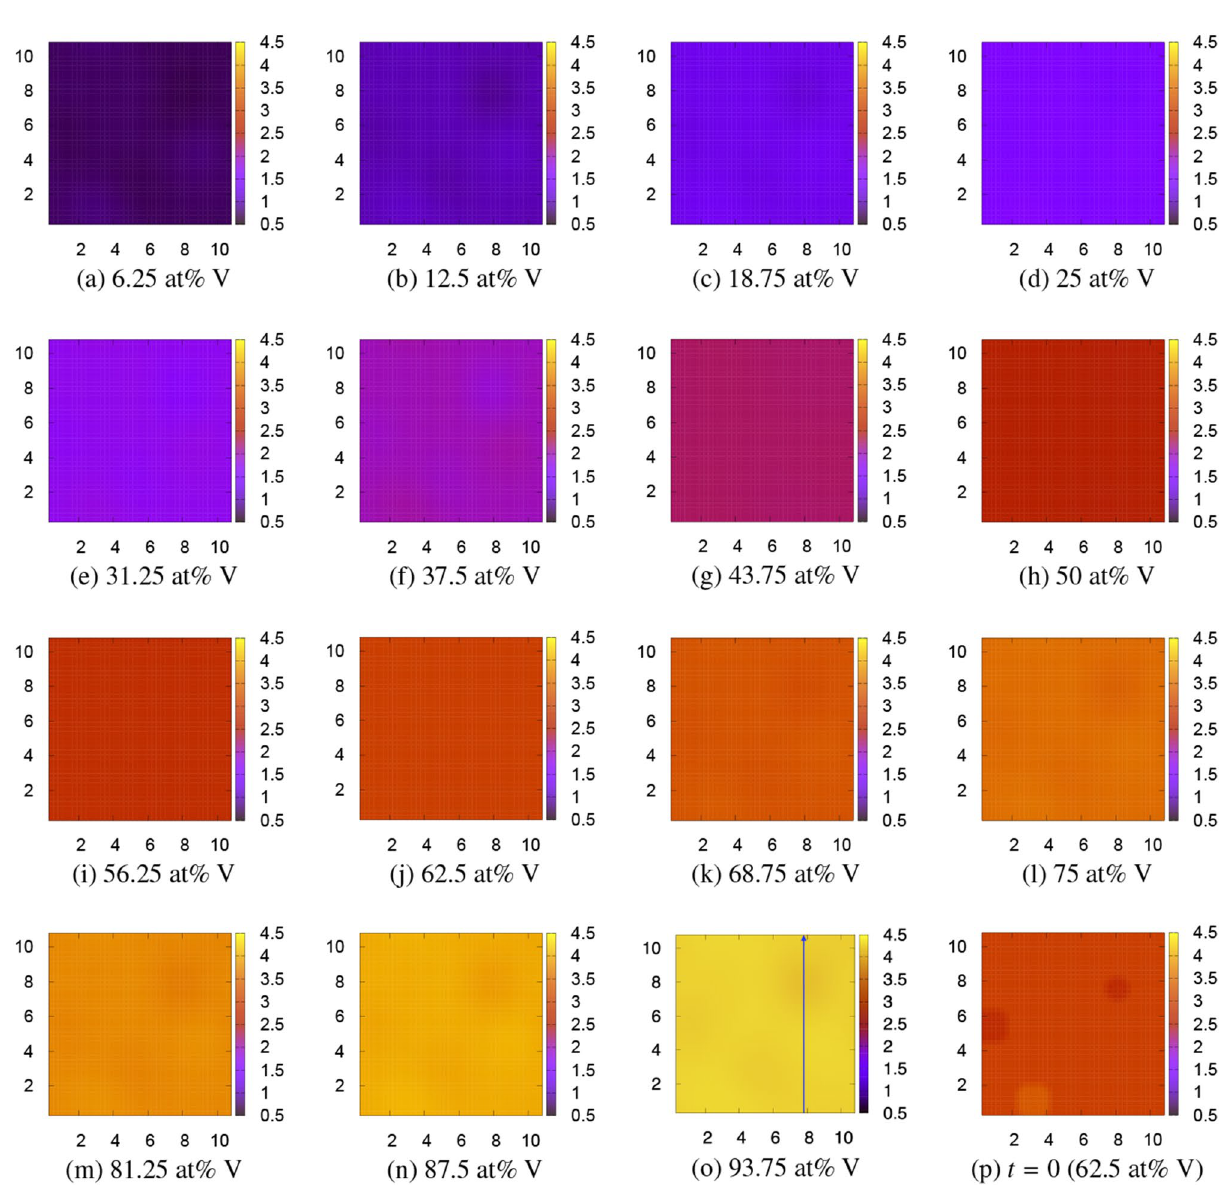
Figure 8. Microstructures of the Ti 4 n V n alloy obtained by the CPF model at 0 K. The color bar indicates the − 0 for 62.5 at% V is shown in ( p ). The scales in x and y 0.5 . The initial pattern at t n V concentration φ V = = + axes can roughly be regarded as the order of μm. The patterns do not change at all at 1300 K. 1D profile along the blue allow of ( o ) 93.75 at% V is depicted in Fig.